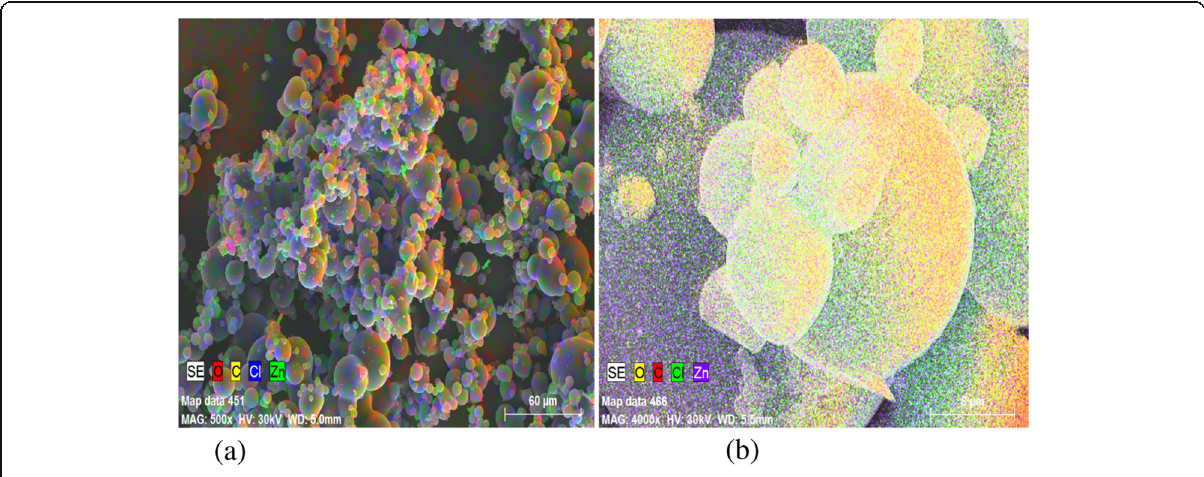
Fig. 2 Energy Dispersion X-ray spectroscopy images of the NPs ( a ) 500 X Mag ( b )